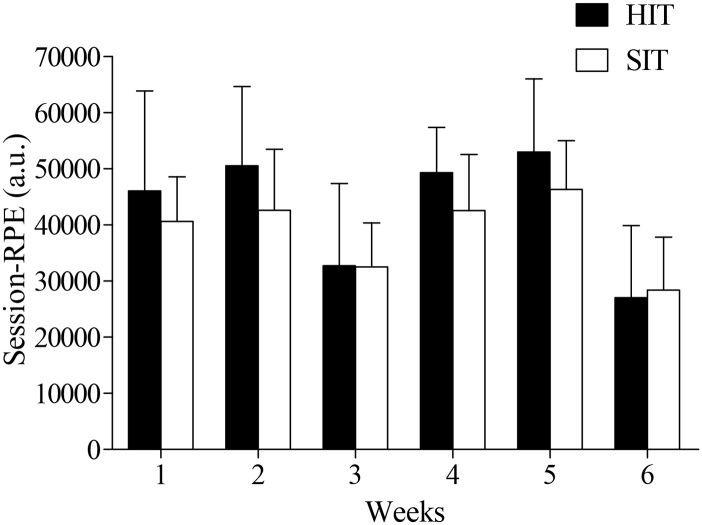
Average weekly training loads of HIT and SIT groups.Calculated using the session rating of perceived exertion (RPE) method, i.e., multiplying the cyclist RPE (using the Category Ratio Scale; CR100) referring to the whole training session by session duration in minutes. HIT—high-intensity aerobic interval training; SIT—sprint interval training; a.u.—arbitrary units.